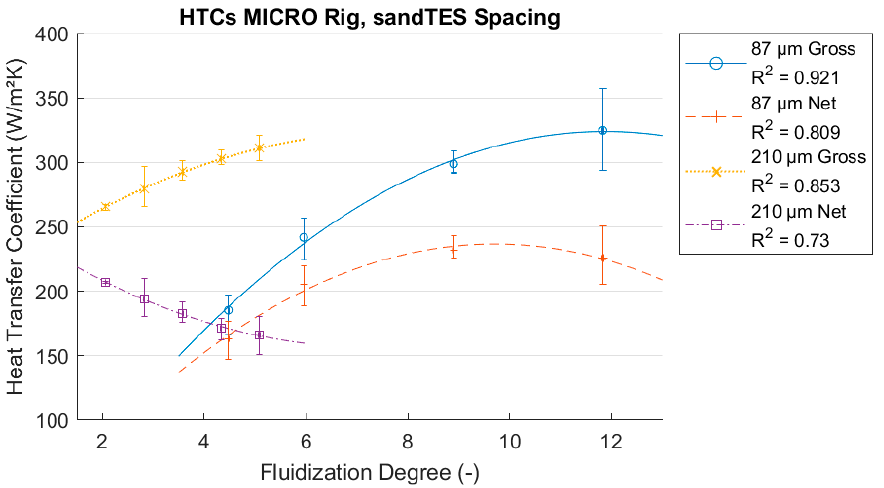
,𝑤 (cid:3040)(cid:3033) (210 µ𝑚) = 43.7 (cid:3040)(cid:3040) , w mf ( 210 µ m ) = 43.7 mm (cid:3046) s